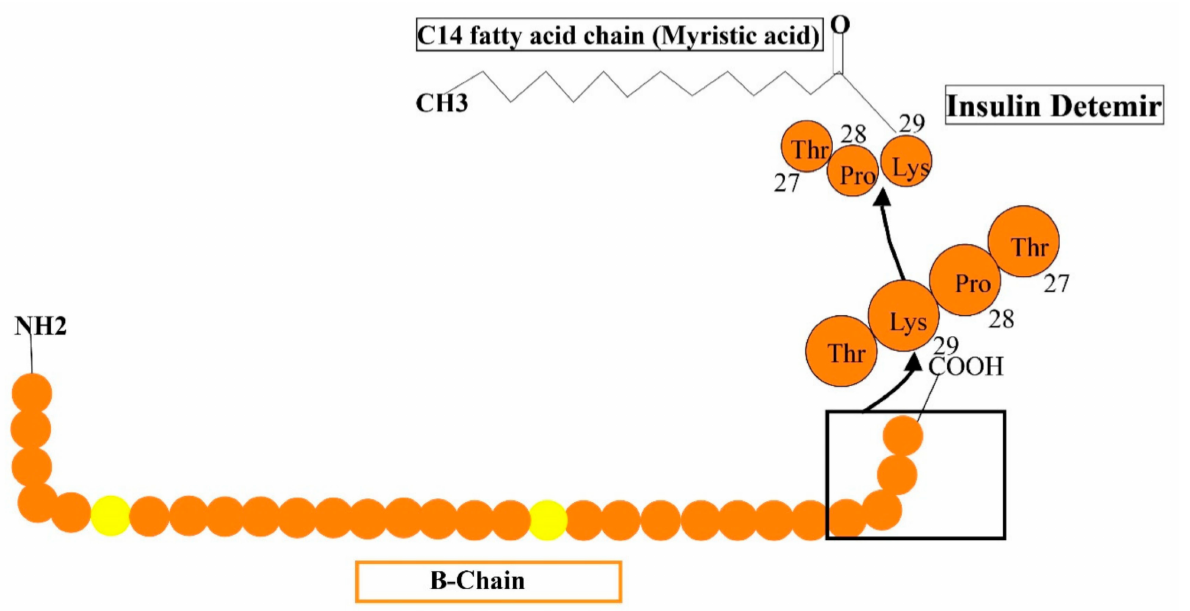
Figure 6. Reveals the formulations of detemir by the addition of some additional structures such as myristic acid is added to lys-29 to human insulin.